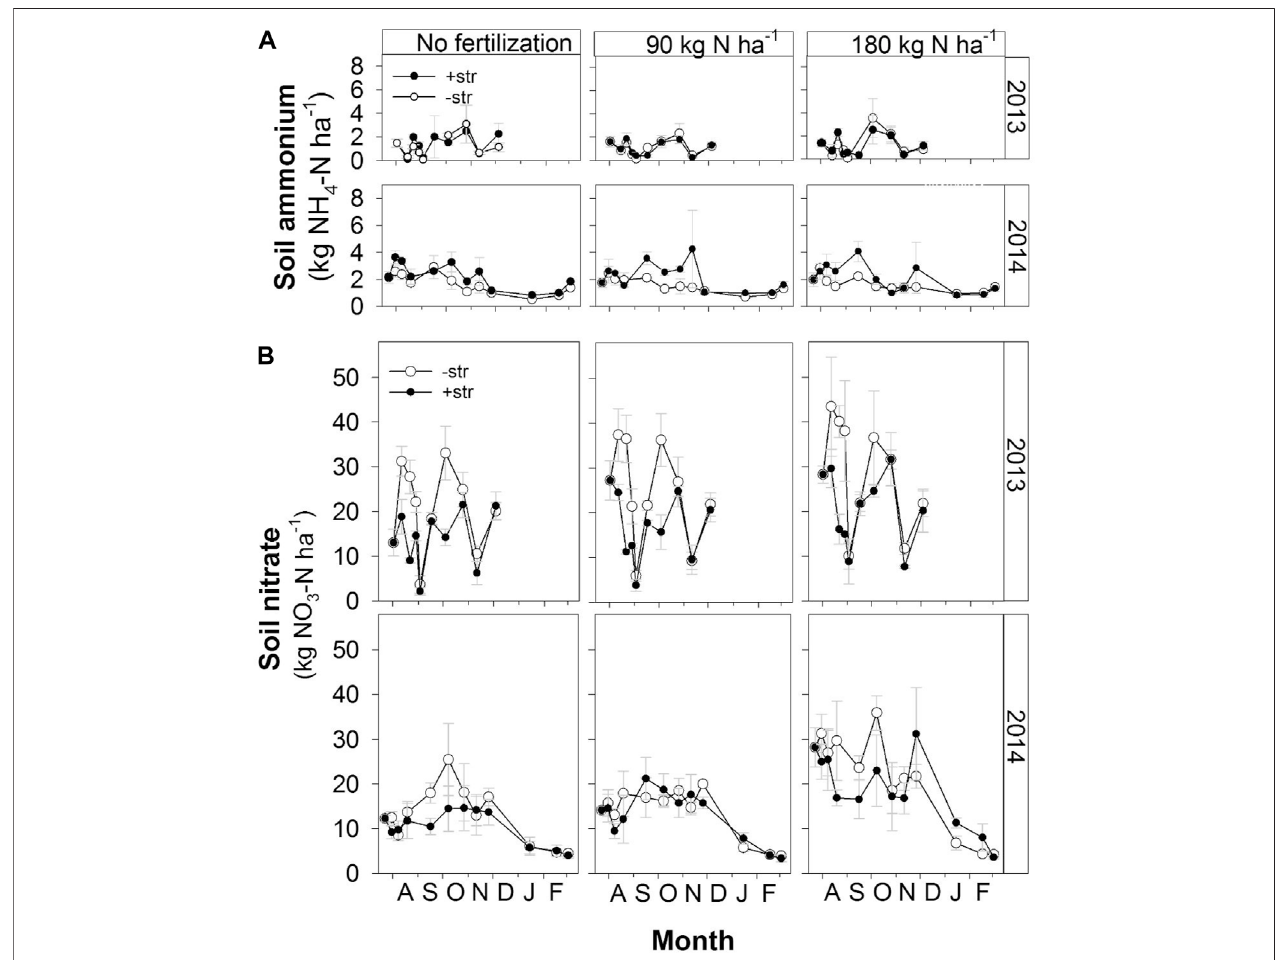
FIGURE 4 | (A) NH 4+ and (B) NO 3 − concentration in the uppermost soil layer (0 – 0.15 m) from soils after oilseed rape harvest without straw incorporation (-str) and incorporation of oilseed rape straw (+str) from the non-fertilized treatment (No fert) and N fertilized treatments (Fert-90: 90 kg N ha − 1 ; Fert-180: 90 kg N ha − 1 ) in spring. Error bars show the standard error of mean of each treatment ( n (cid:2) 3).